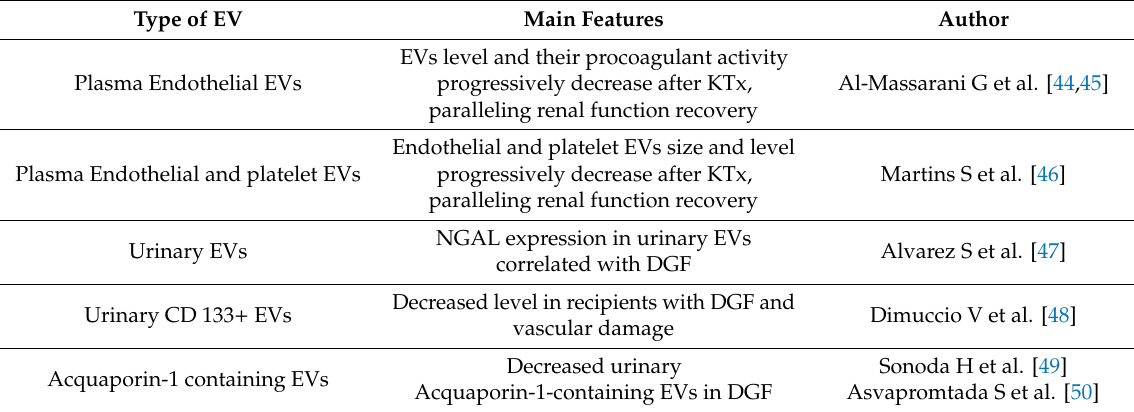
Table 3. Extracellular vescicles (EVs) as potential biomarkers of